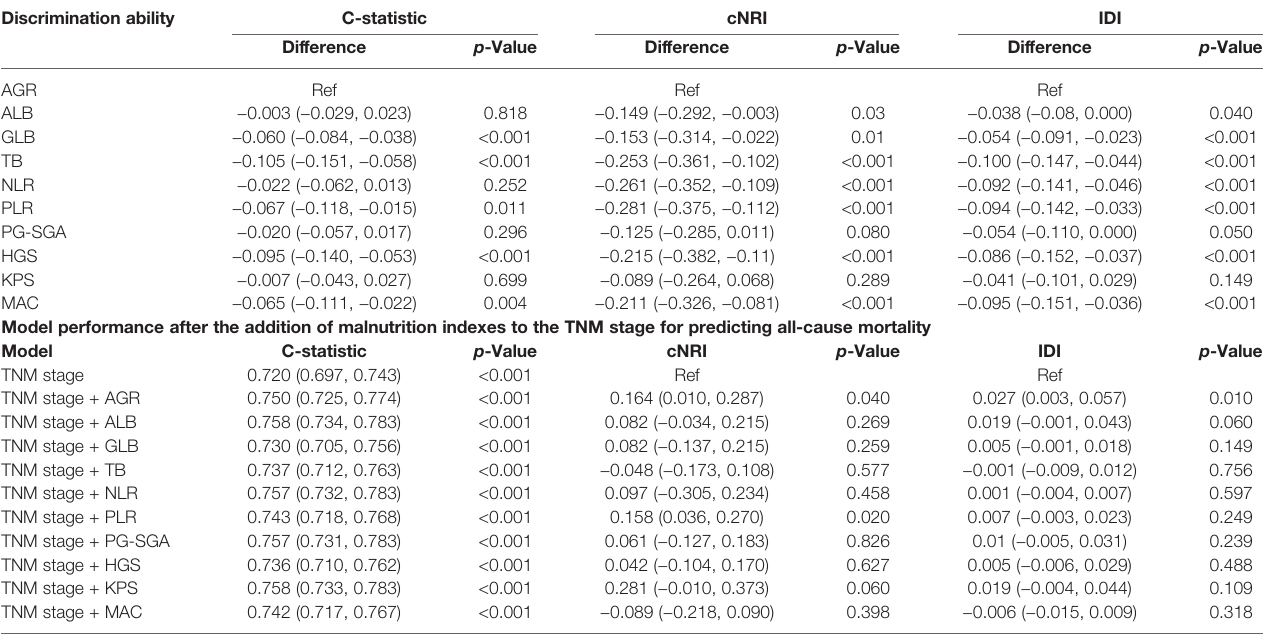
TABLE 5 | Comparative analysis of the discrimination of each malnutrition score for all-cause mortality in validation